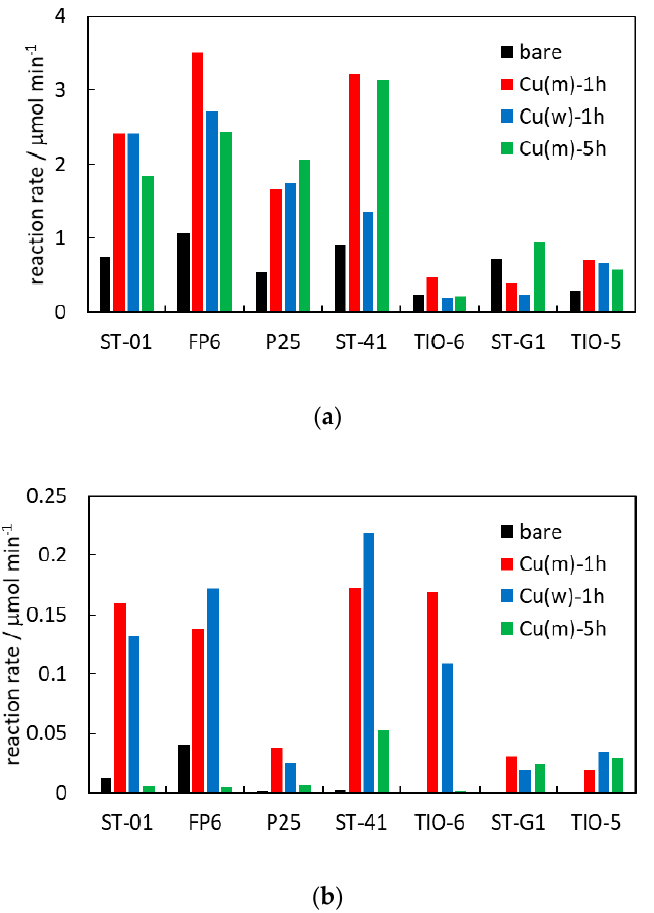
Figure 5. Comparison of photocatalytic efficiency for acetic acid decomposition under: ( a ) ultraviolet/visible (UV/vis) and ( b ) vis irradiation.